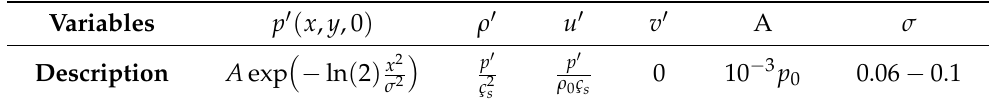
Table 2. Parameters for the planar pulse wave.